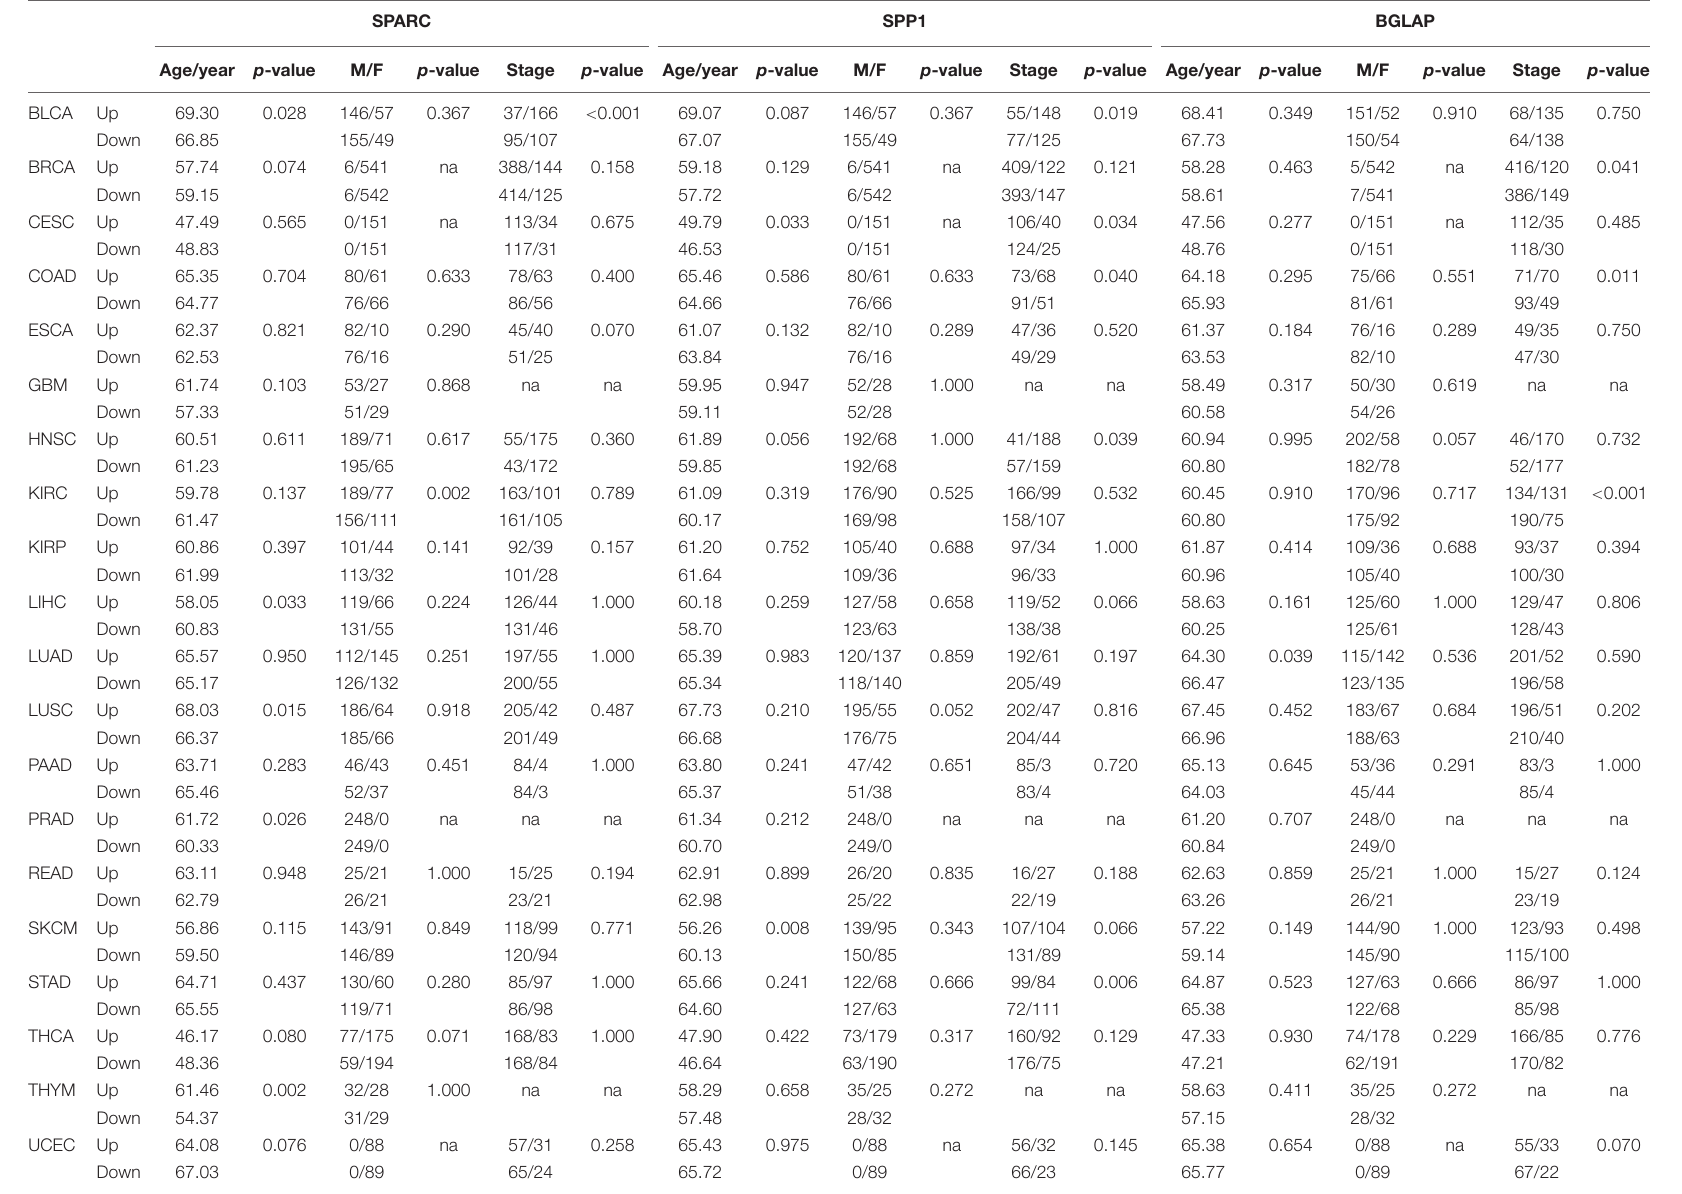
TABLE 2 | Correlations between expression levels of osteomimetic markers and clinical features in different cancer